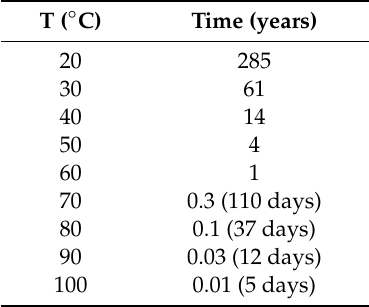
Table 5. Half-life for chitin samples extracted from Vespa velutina at di ff erent